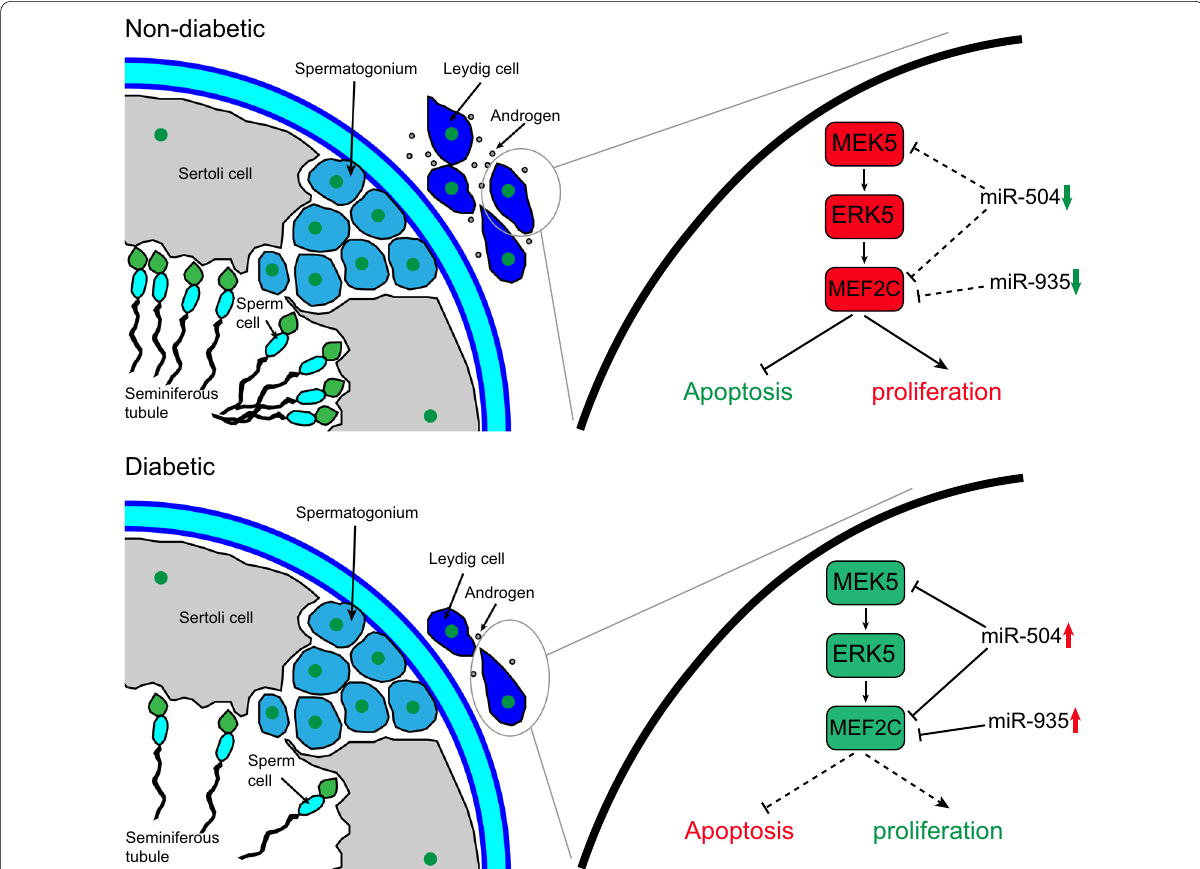
Fig. 7 Schematic showing the molecular mechanisms of diabetes-induced testicular damage. Notes: In the diabetic state, the expression of miR-504 and miR-935 in Leydig cells increases, thereby inhibiting the MEK5/ERK5/MEF2C pathway, leading to increased interstitial cell apoptosis and inhibition of proliferation. This results in a reduced secretion of androgens, which in turn leads to a decrease in sperm production. Green indicates inhibition, whereas red indicates enhancement. Solid lines to indicate enhanced effects and dotted lines to indicate weakened stimulatory or inhibitory